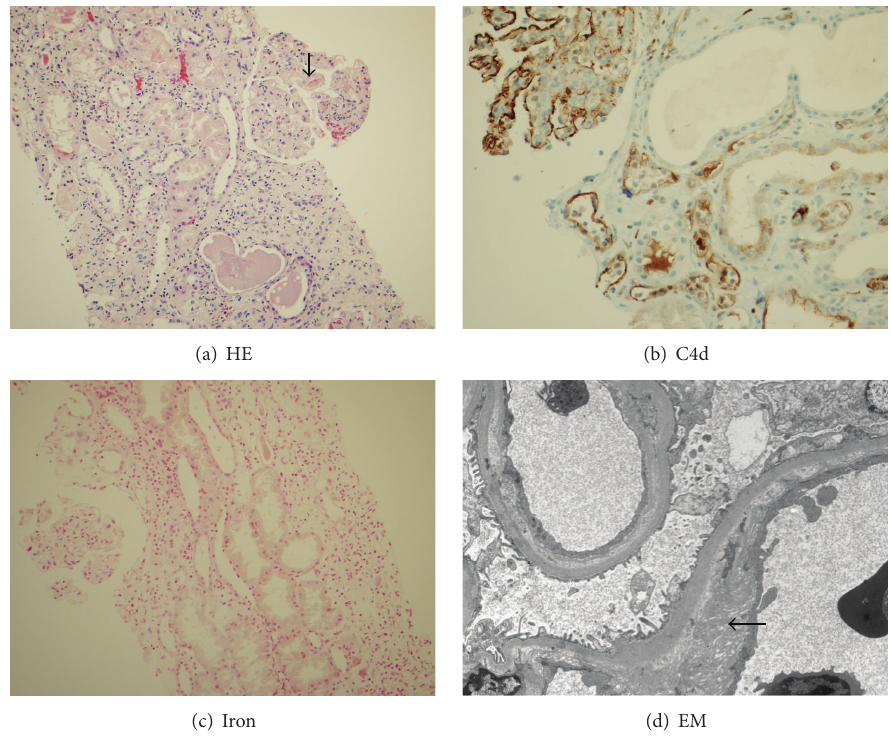
Figure 2: Acute tubular injury caused by type 2 antibody-mediated rejection in the allograft kidney. (a) Light microscopy showed a glomerulus with lobular configuration and focal fibrin thrombi (arrow). Renal tubules are mildly dilated with mild tubulitis. Interstitial mononuclear infiltrate is also seen (hematoxylin and eosin, original magnification × 100). (b) C4d diffusely positive in peritubular capillaries and glomerular capillary loops (original magnification × 200). (c) Iron staining is essentially negative (original magnification × 100). (d) Electron photomicrograph showed double contoured glomerular capillary loops with lucency and subendothelial deposit of fibrin (arrow), consistent with thrombotic microangiopathy (original magnification ×